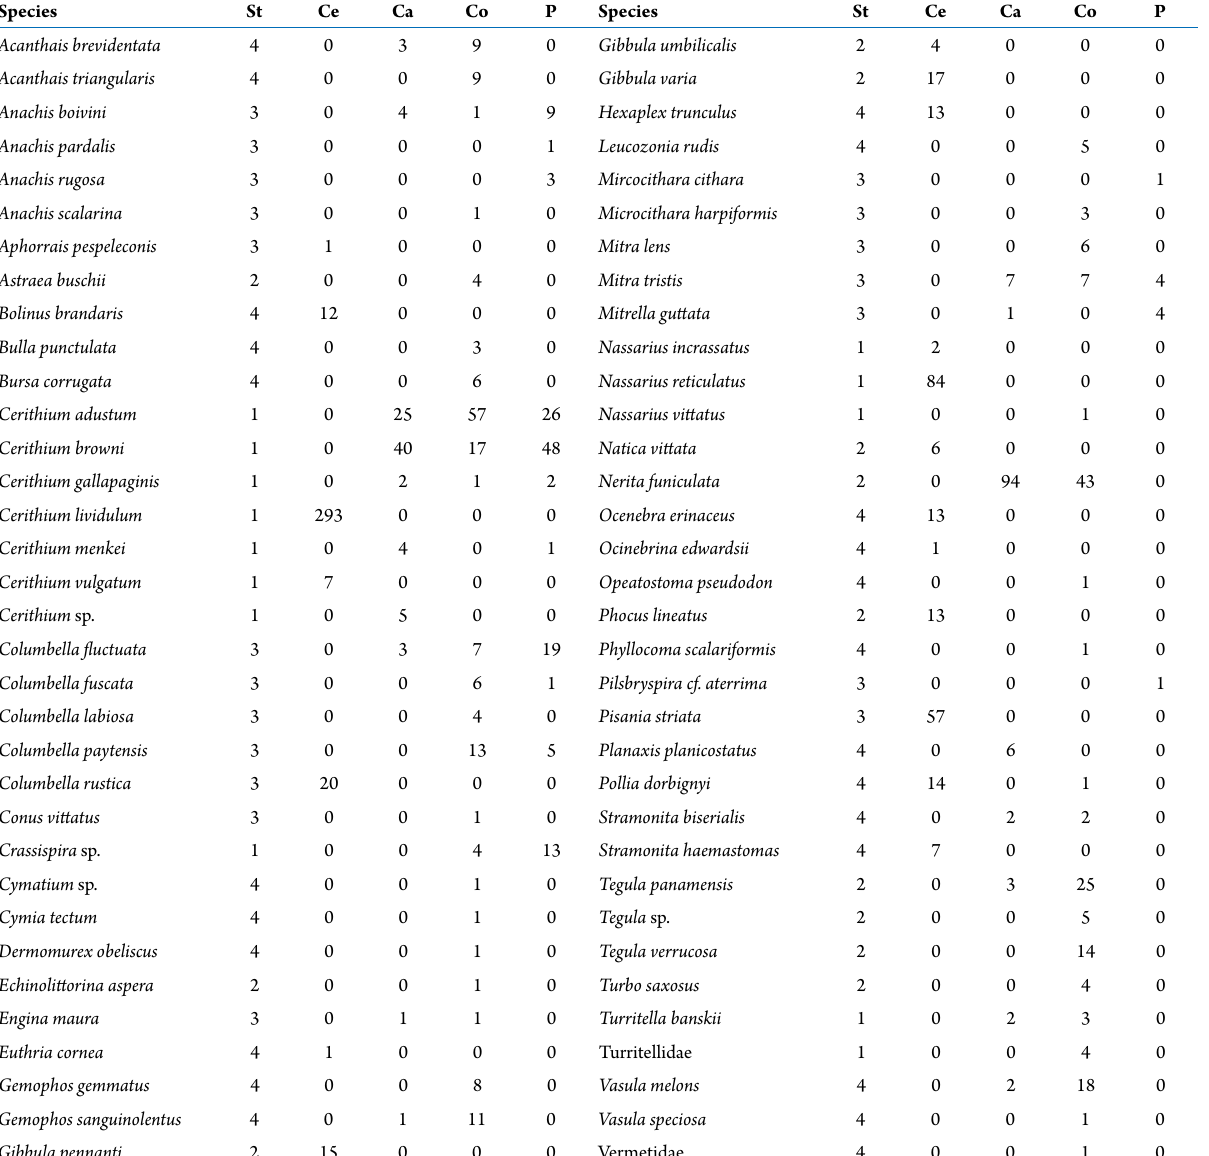
Table 2. Number of hermit crabs that were found occupying shells of different gastropod species in the studied intertidal habitats. Abbreviations: ( Ce ) Clibanarius erythropus from Spain; ( Ca ) Clibanarius albidigitus , ( Co ) Calcinus obscurus, and ( P ) Paguristes sp. from the Pacific coast of Costa Rica; (St) morphological shell type 1, 2, 3 or 4 (see Material and Methods and Fig.